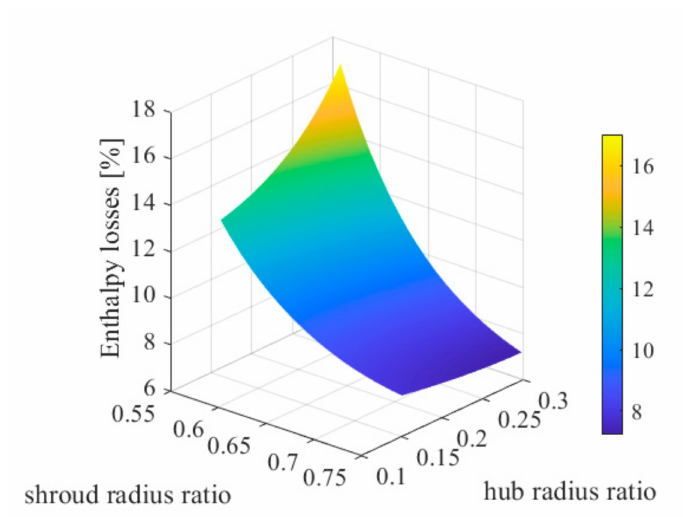
Figure 15. Variation of the enthalpy losses with shroud radius ratio and hub radius